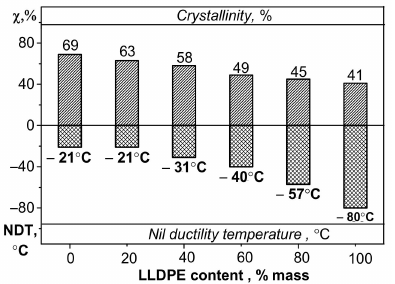
Figure 13. The effect of weight fraction of LLDPE on nil ductility